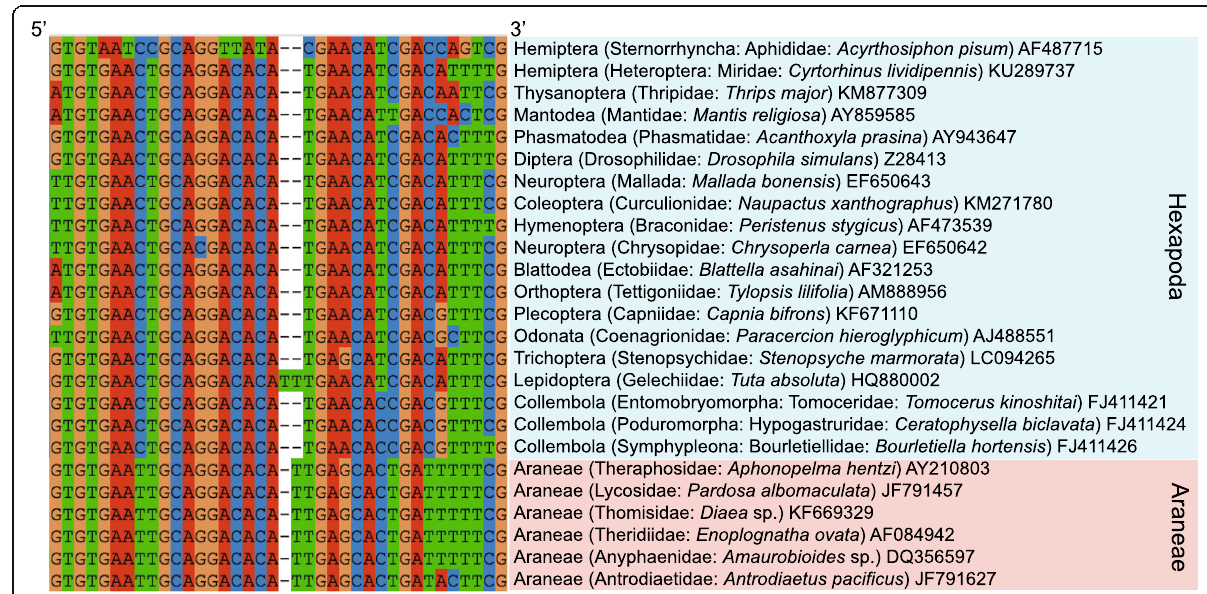
Fig. 1 Forward primer position within 5.8S rRNA region. Around the insertion/deletion site within the 5.8S rRNA region, nucleotide sequences are well conserved within Hexapoda except for Lepidoptera and Sternorrhyncha. Hexapoda, and Araneae primers and Araneae-specific blocking primers were developed around the insertion/deletion site (Table 1)